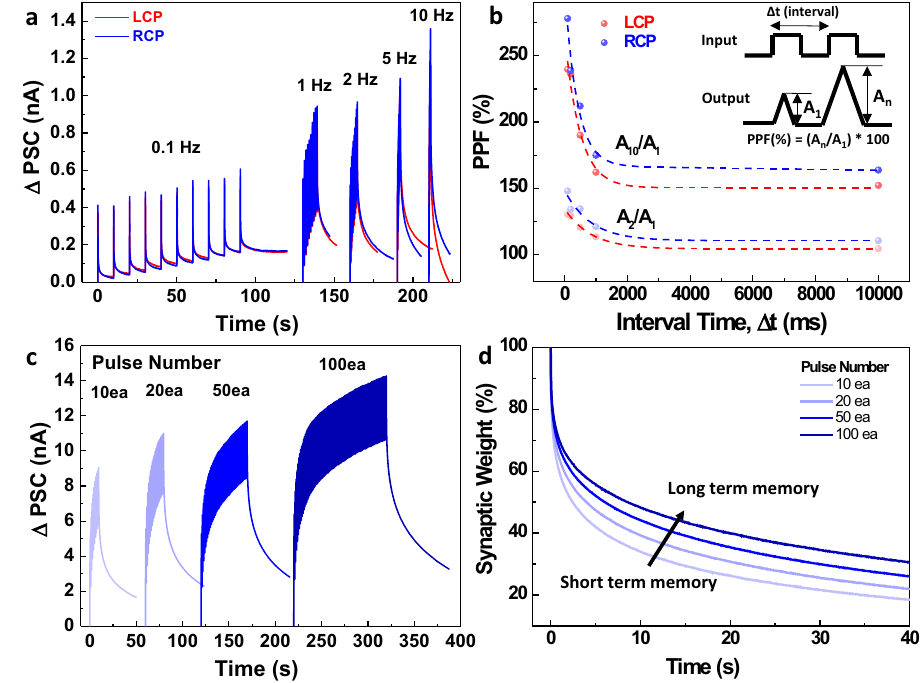
Fig. 6 | Synaptic Characteristics of CPL-Detecting Transistor. a Delta post synaptic current under CPL pulse illumination at 635nm depending on frequency. Thelightintensitywassetto4.9mW( b )PPF(pairedpulsefacilitation)asafunction of pulse interval time. The graph is fi tted into double exponential function: y=A 1